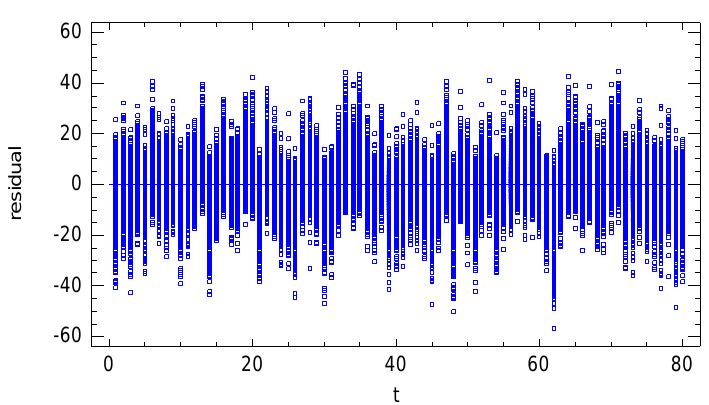
Figure 3. Residuals vs. sequential factor t